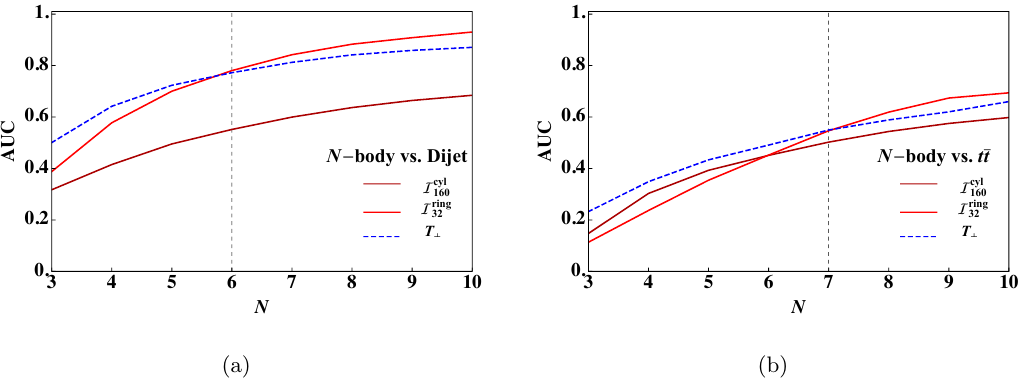
Figure 19 . The AUC values as a function of N for discriminating uniform N -body decays of a 1 TeV resonance from (a) QCD dijet events and (b) t (cid:22) t events. Shown are cylindrical event isotropy, ring-like event isotropy, and transverse thrust, as computed in pp collisions at general, transverse thrust is a better discriminant for low multiplicity events, but ring-like event isotropy is a better discriminant beyond N = 6 ( N = 7) for the dijet ( t (cid:22) t ) background. Values of AUC < 0 : 5 occur when the SM sample is more isotropic than the N -body phase space sample according to the event shape observable.